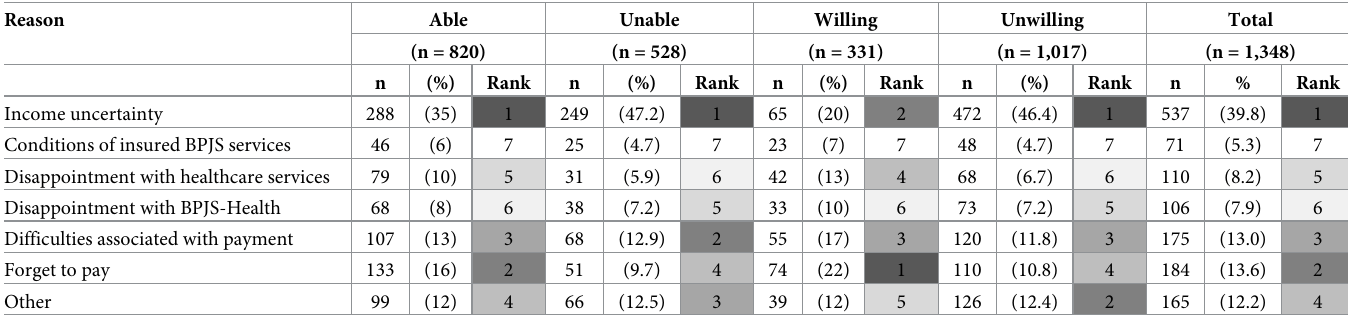
Table 8. Reasons for lapsing in JKN premium